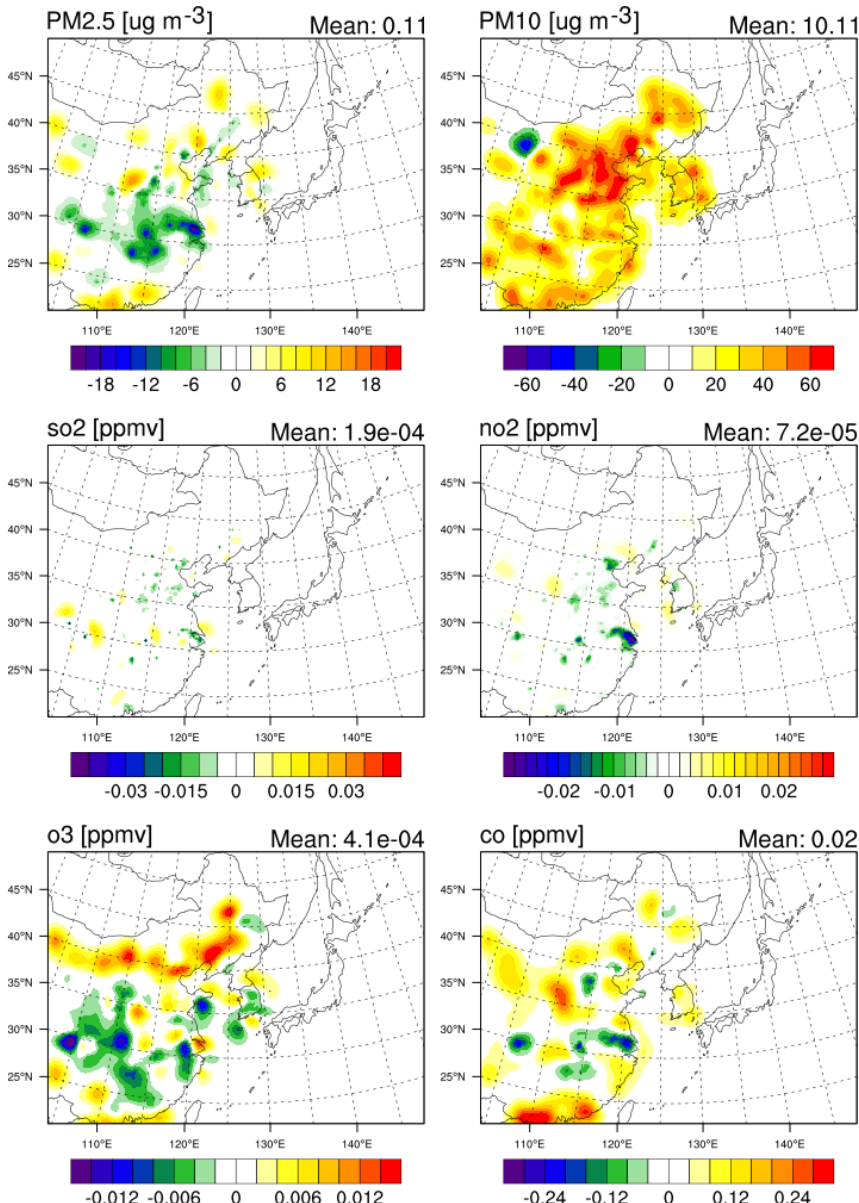
Figure 9. Horizontal distribution of the analysis increments in particulate matter concentrations and four gas species at the lowest model level over domain 1 in the DA experiment, averaged for 7–31 May 2016. The domain average is shown in the top right corner of each panel. Table 4. Air quality index values, as defined in the NIER in